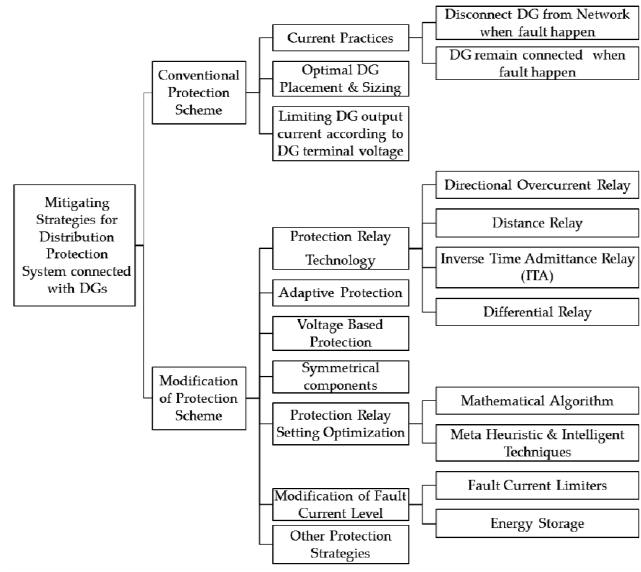
Figure 1. Protection strategies to mitigate the impact of DGs on DNs.